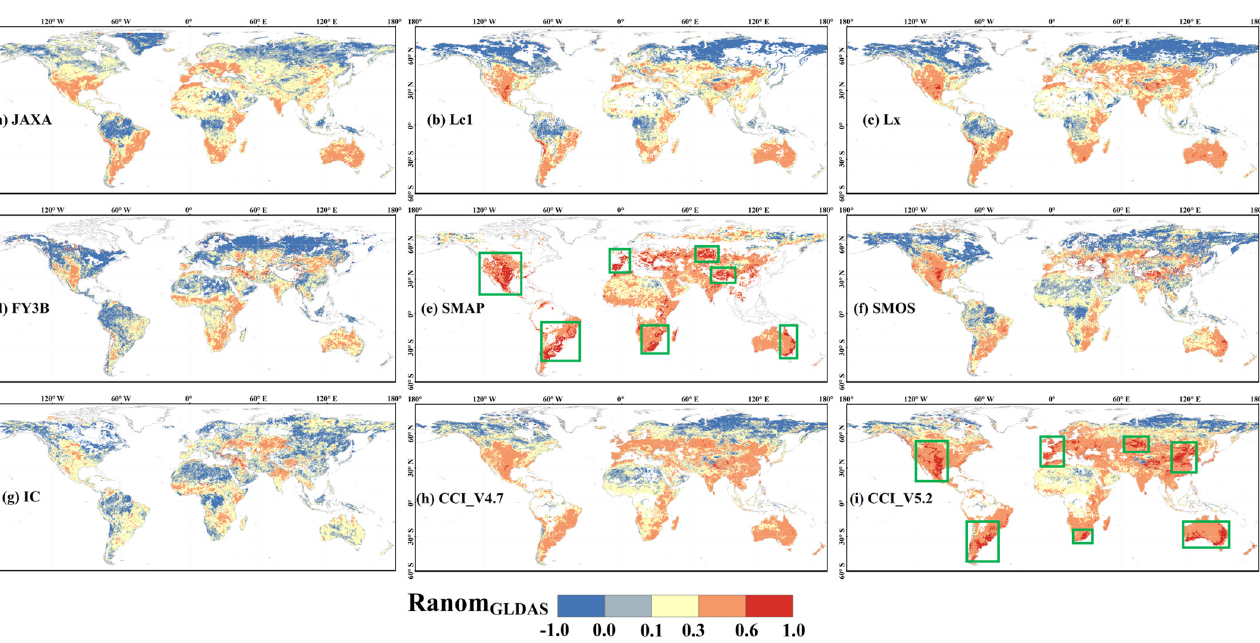
Figure 7. Spatial distribution of R against GLDAS for ( a ) JAXA, ( b ) Lc1, ( c ) Lx, ( d ) FY3B, ( e ) SMAP, ( f ) SMOS, ( g ) IC, ( h ) CCI_V4.7, and ( i ) CCI_V5.2. The regions with R > 0.6 are outlined with yellow boxes.